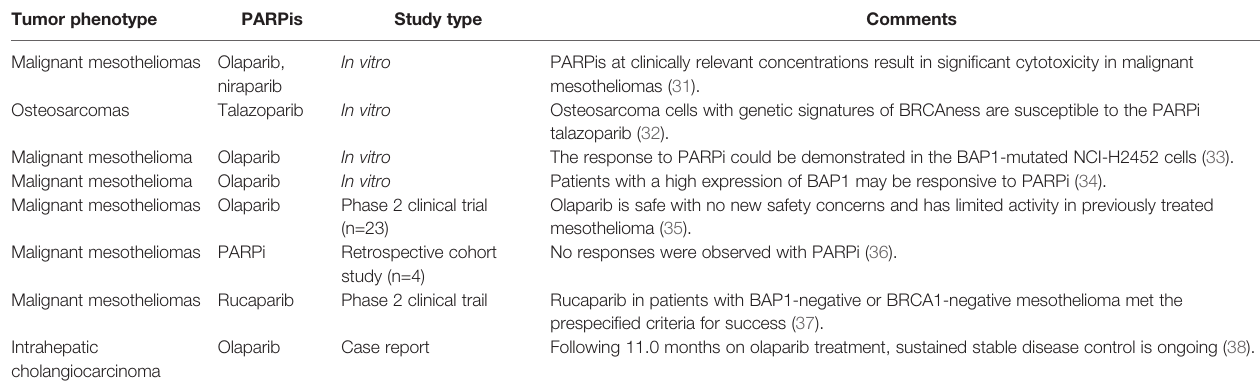
TABLE 1 | Studies of PARPi in tumors with BAP1